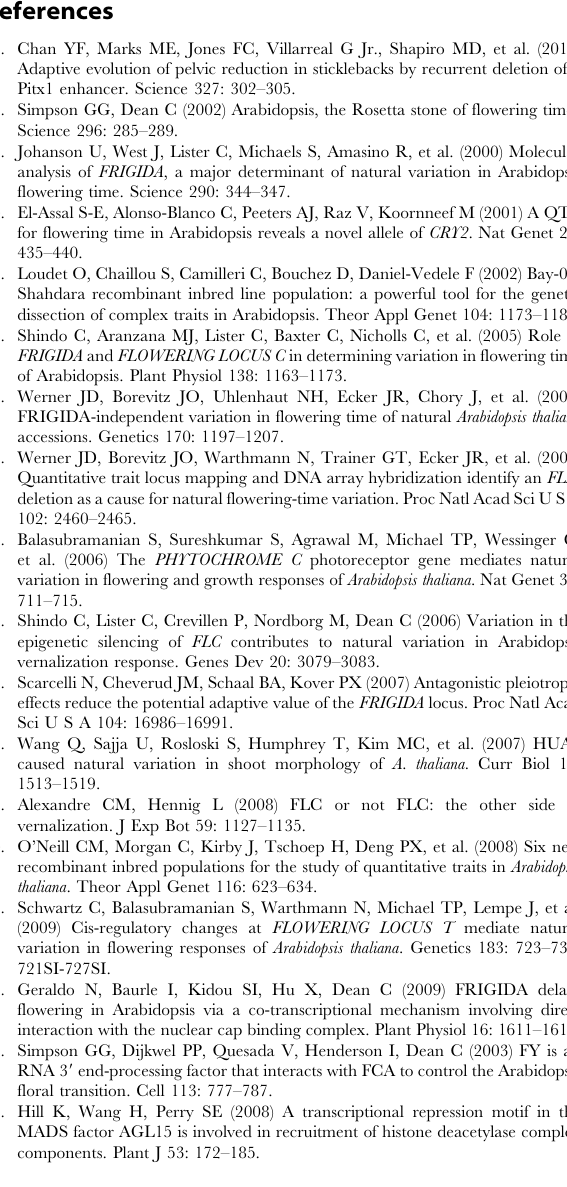
Table S3 Alignment of FT regulatory sequences of Col- 0, Ull-2-5 and